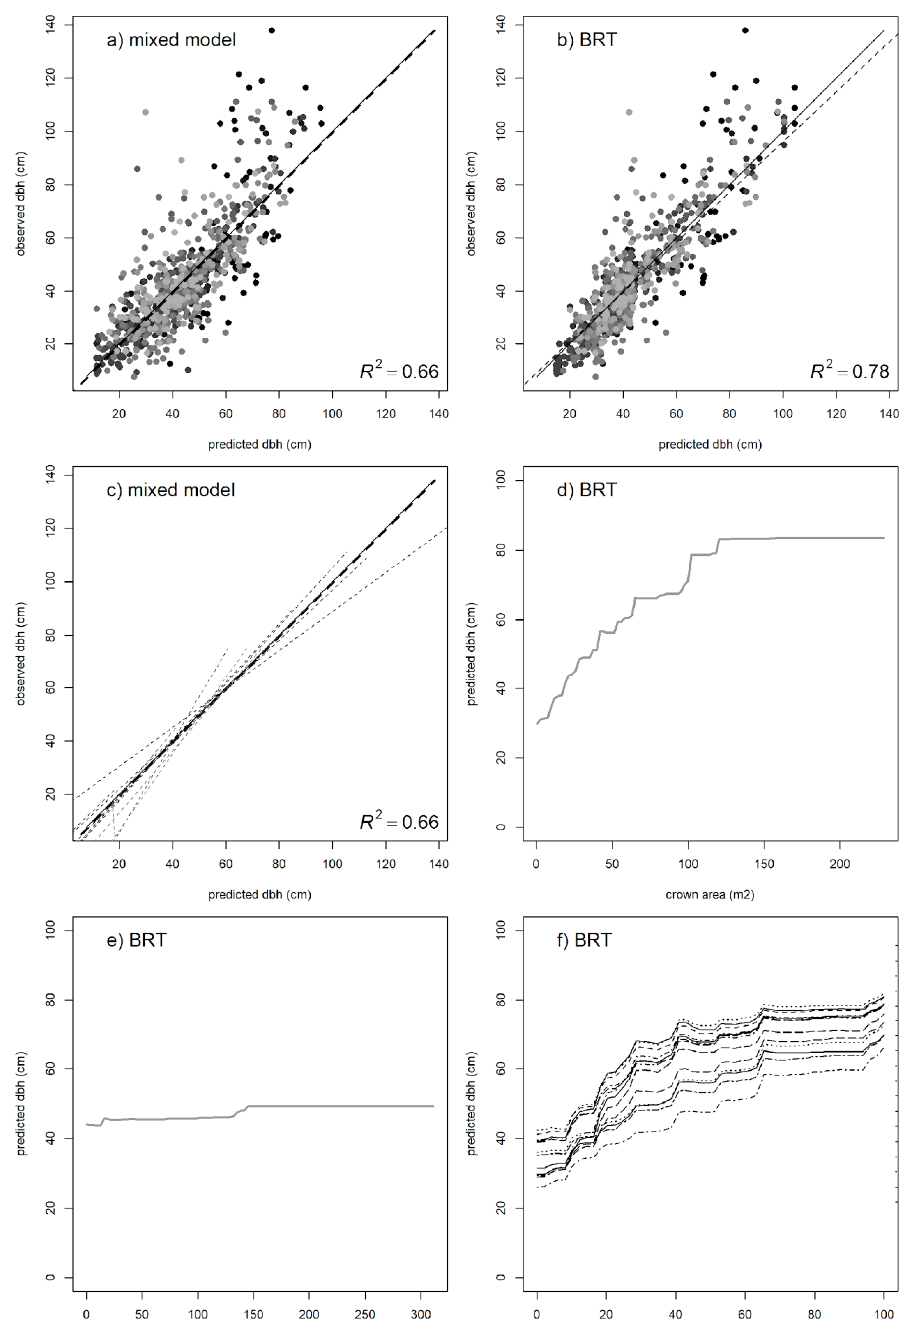
Figure 7. Predicted DBH values for the ( a ) mixed model and ( b ) boosted regression trees (BRT). ( c ) Using crown area as the main variable (main effect in bold line) and incorporating between-species predictions (N = 12, discontinuous lines) as a random factor as compared with BRT marginal effects for ( d ) crown area, ( e ) crown volume, and ( f ) each individual species. In the mixed model, the between-species standard deviation was 6.81 for an estimated residual deviation of 12.06. The main contributions for the BRT model were crown area (68.9%), species (16.9%), and crown volume (6.97%), the others being below 5%.